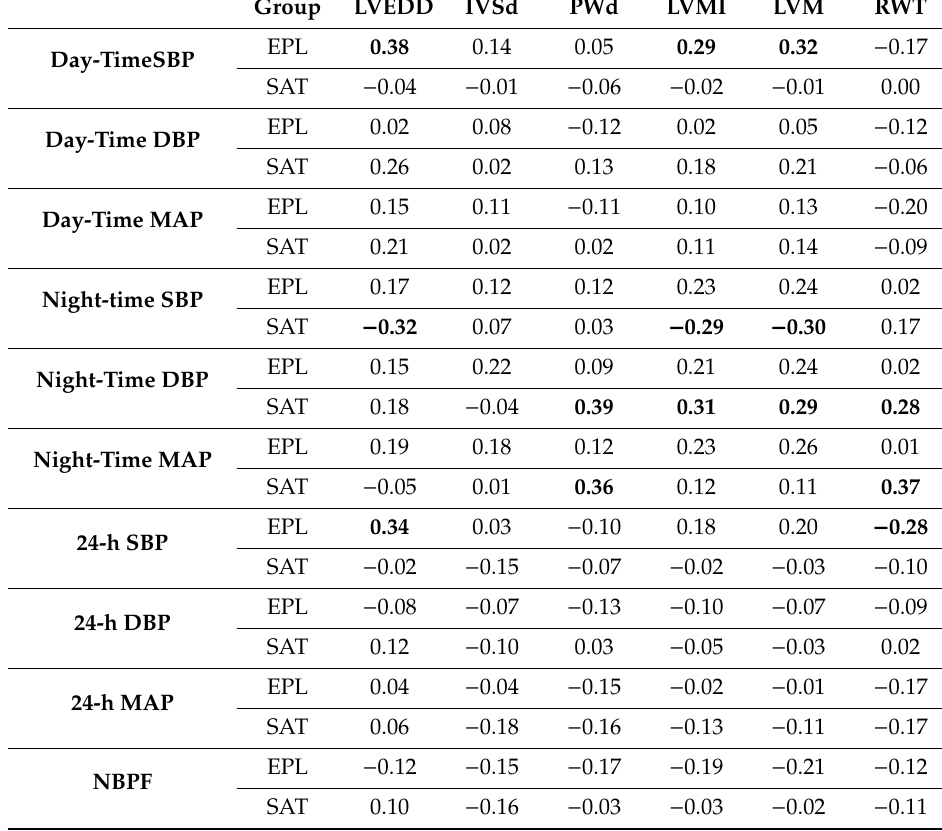
Table 5. Relationship (Spearman’s correlation coe ffi cients) between changes in BP (between Visit 1 and 2) and changes in echocardiographic parameters after 6 months in eplerenone-treated and in placebo group. Statistically significant correlations are marked in